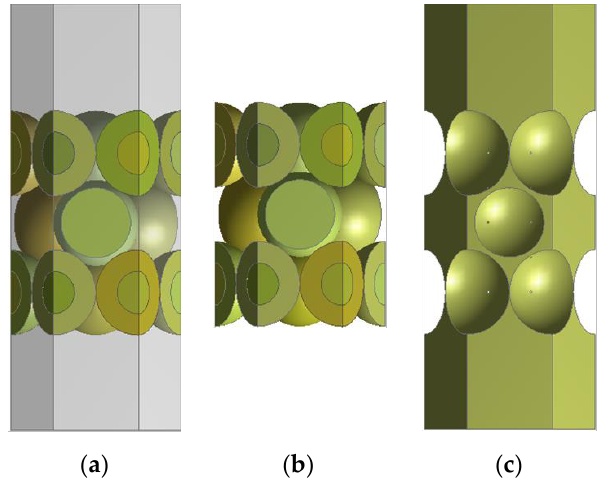
Figure 1. ( a ) Full geometry, ( b ) the solid part, and ( c ) the fluid part of the pebble bed. Table 1. Properties of the materials used in the simulation. Table 1. Properties of the materials used in the